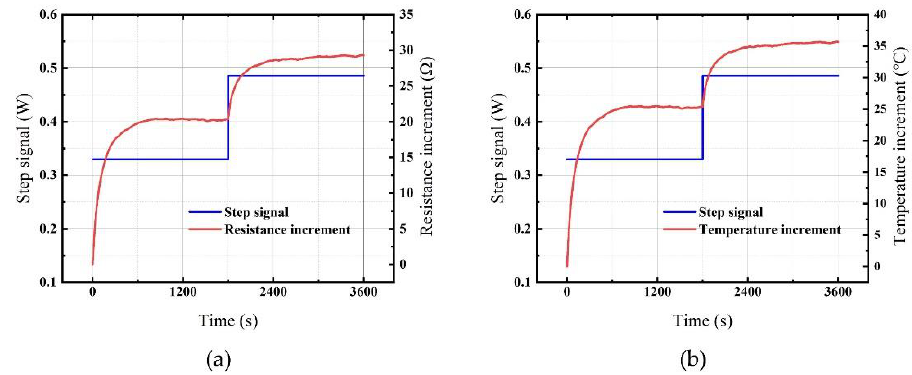
Figure 5. Step response curves. ( a ) Resistance increment; ( b ) temperature increment.